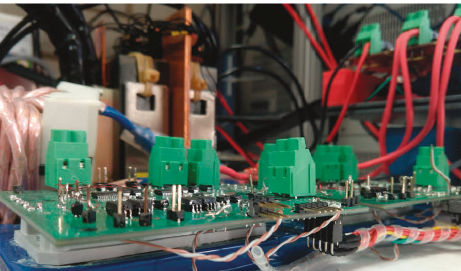
Figure 11: PSFB prototype used for experimental validation of proposed control scheme. The modular structure allows for flexible testing of different combination of power device.